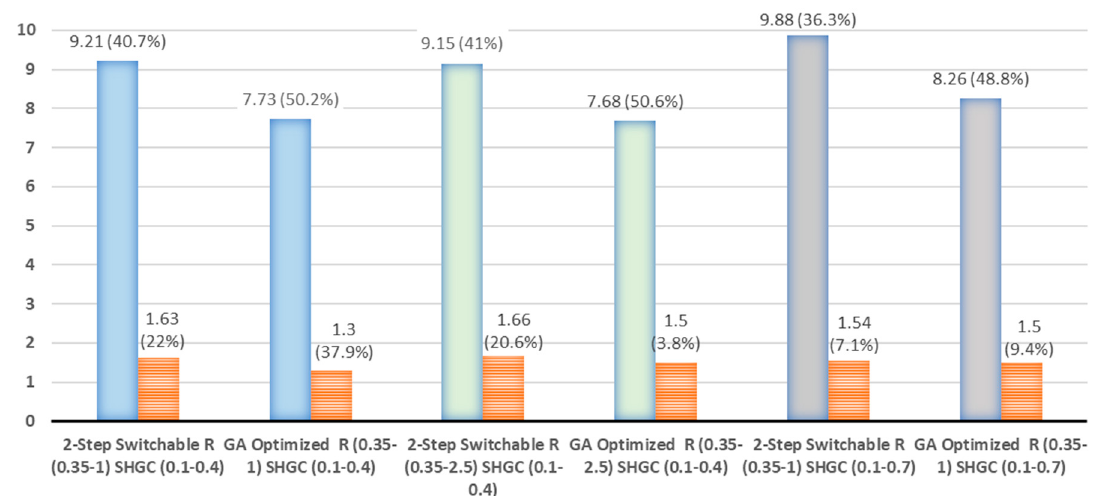
Figure 13. HVAC loads and electrical peak demand for STIS–smart windows applied to a house in Golden, CO, USA during 21 May, with various R-value and SHGC settings.